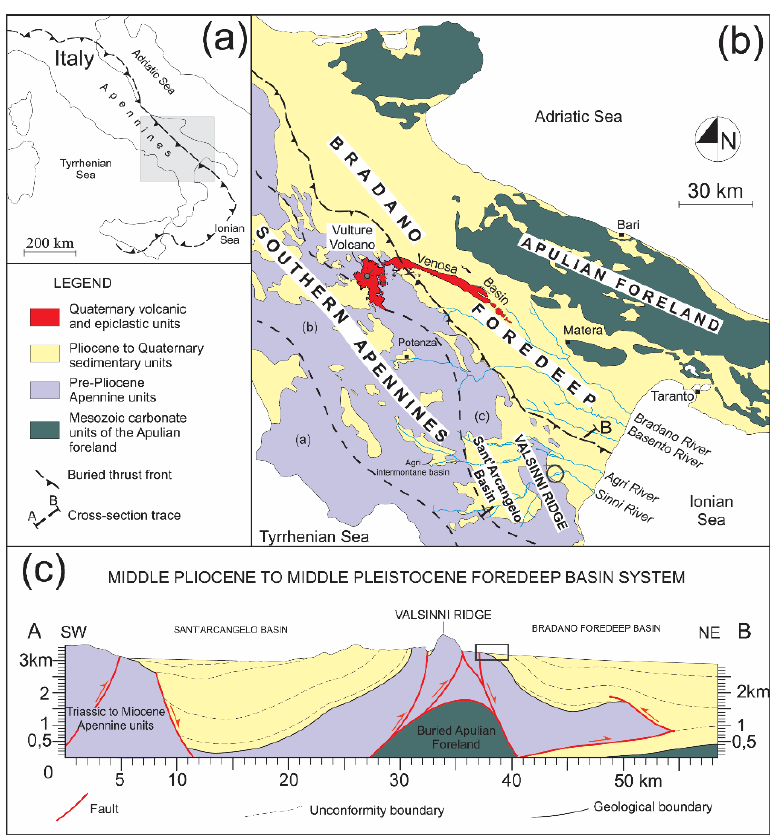
Figure 1. Location of the study area ( a ); geological sketch map of southern Italy ( b ) and geological cross-section ( c ) of the eastern front of southern Apennine chain (modified after [20,30]). Circle in ( a ) and rectangle in ( b ) indicate the investigated area. Please note that the vertical scale in ( c ) does not refer to the elevation a.s.l.